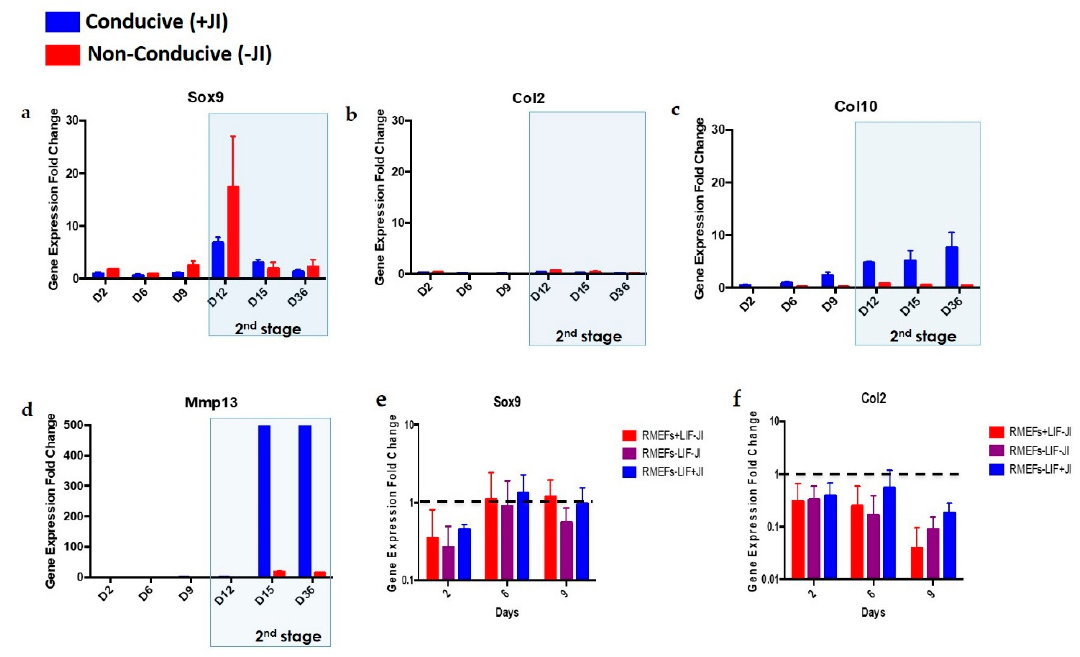
Figure 4. Effect of JI1 to the chondrogenic gene expression kinetics of transdifferentiated aggregates. Cells were transdifferentiated (day 2 to 36) under a conducive and non-conduce media. ( a ) Sox9 expression demonstrated its upregulation on day 12 (2nd stage) with later gene expression reduction toward the end of the process. Levels of expression were similar for both conditions. ( b ) Col2 expression was not upregulated in either condition at any time in the process. ( c ) Col10 was expressed at a higher level in cells under conducive media and expression levels increased with time. No Col10 expression under non-conducive media. ( d ) The Mmp13 gene was upregulated under conducive media on day 15, and this continued up to day 36. The Mmp13 gene was not present in non-conducive media. ( e , f ) MEFs do not undergo spontaneous chondrogenesis during the first stage of trans-differentiation either in the presence or absence of LIF or JI1. OSKM-transduced MEFs were cultured in three different conditions ( − LIF/+JI1, − LIF/ − JI1 and +LIFJI1) and samples on days 2, 6, and 9 were analyzed for Sox9 and Col2 gene expression. Both Sox9 and Col2 genes showed insignificant upregulation at all time points and conditions.